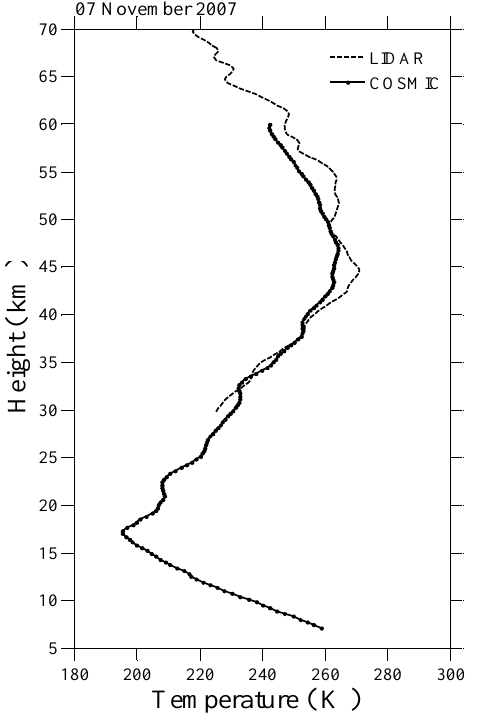
Fig. 7. Height profile of temperature measured by LIDAR and Figure 7: Height profile of temperature measured by LIDAR and COSMIC over Reunion for 3 COSMIC over Reunion for 7 November